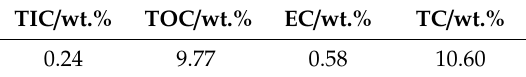
Table 2. Carbon analysis of fines; TIC = total inorganic carbon, TOC = total organic carbon, EC = elemental carbon, and TC = total carbon.